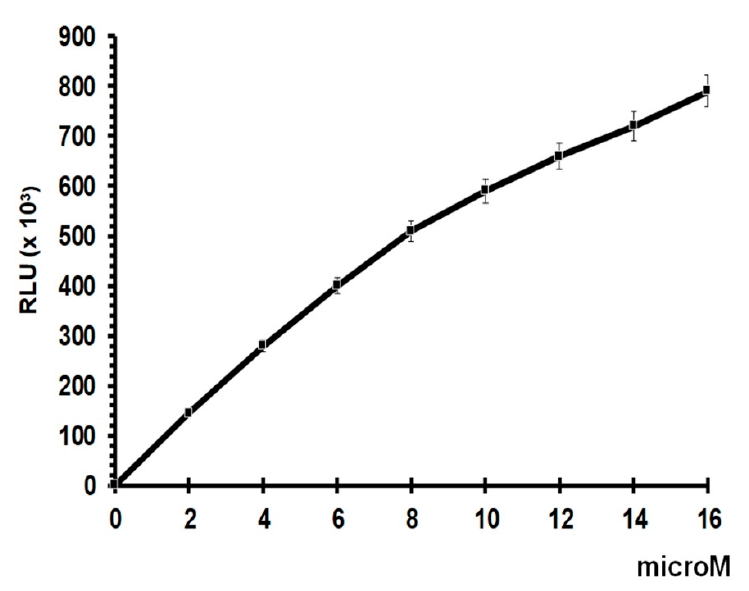
Figure 2. Glutathione standard curve. Antioxidants 2020 , 9 , 1291